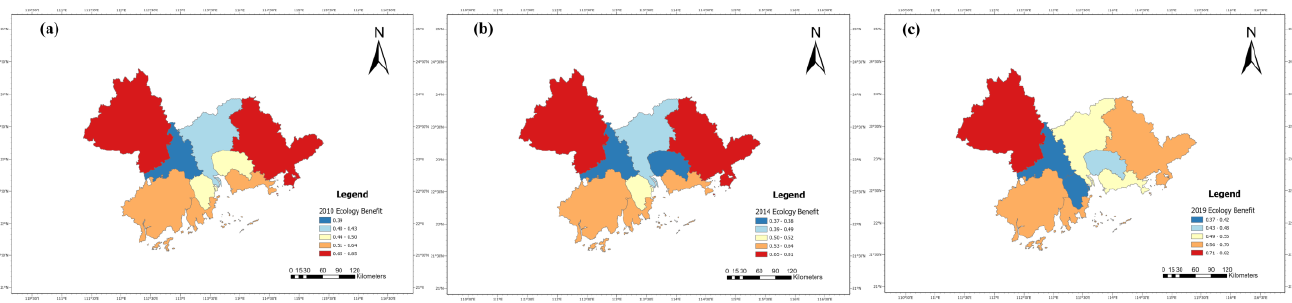
Figure 10. The benefit index of the eco-environment system in the PRD in ( a ) 2010, ( b ) 2014, and ( c )